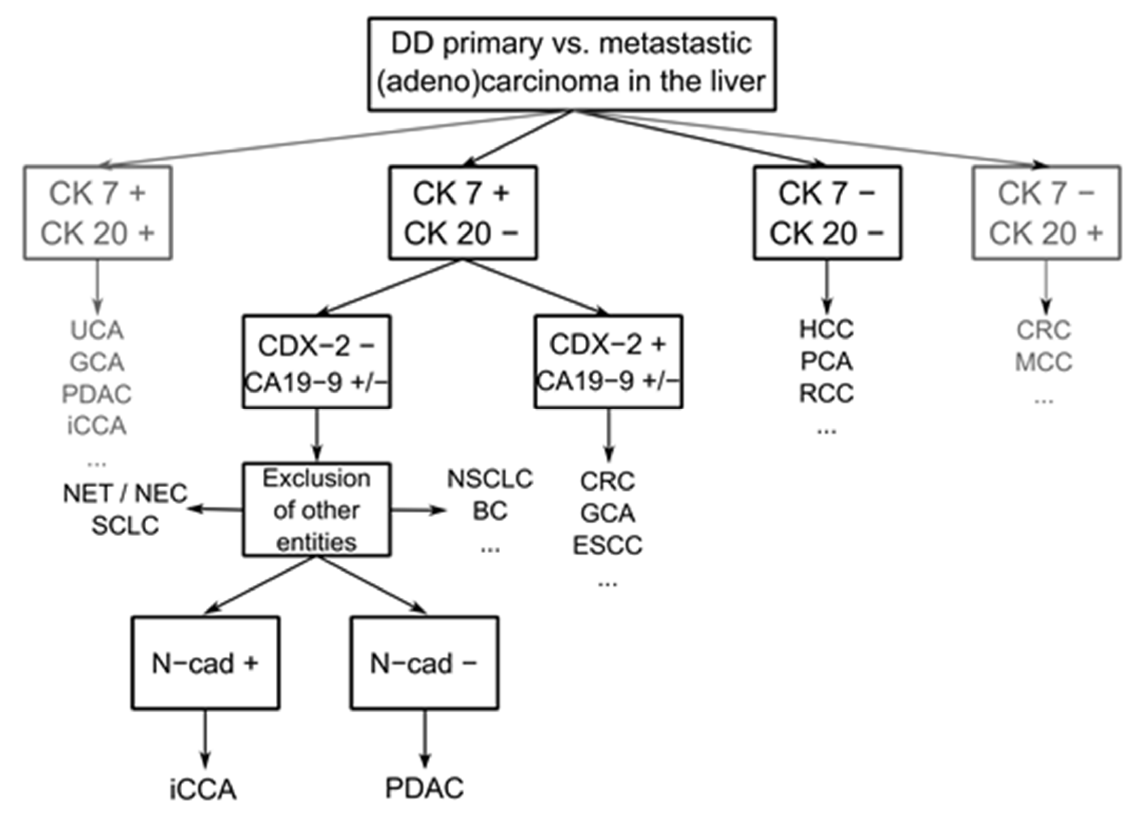
Figure 6. Schematic immunohistochemistry workflow for the differential diagnosis of metastatic and primary adenocarcinomas of the liver. N-cadherin may be used to differentiate the origin of CK7+/CK20 − and CDX2-/CA19-9 − /+ pancreatobiliary adenocarcinomas. BC: breast carcinoma. CRC: colorectal carcinoma. ESCC: esophageal squamous carcinoma. GCA: gastric carcinoma. HCC: hepatocellular carcinoma. MCC: Merkel cell carcinoma. NEC: neuroendocrine carcinoma. NET: neuroendocrine tumor. NSCLC: non-small cell lung cancer. PCA: prostate cancer. RCC: renal cell carcinoma. SCLC: small cell lung cancer. UCA: urothelial carcinoma. Supplementary Materials: The following supporting information can be downloaded at: https: tions of pancreatic ducts; Figure S2: E- and N-cadherin expression in carcinomas of the pancreatobil- iary system; Figure S3: Survival analysis of E- and N-cadherin protein expression in iCCAs of our cohort in comparison to CDH1 and 2 mRNA expression in the independent TCGA cohort; Figure S4: the uncropped Western blots; Table S1: patient characteristics of iCCA for the survival analysis (own cohort), separated by high and low N-cadherin H-scores; Table S2: Summary of evaluation of CK7 staining; Table S3: of CA19-9 staining; Table S4: of EMA staining; Table S5: of CDX2 staining; and Table S6: of CK20 staining in the cohort.